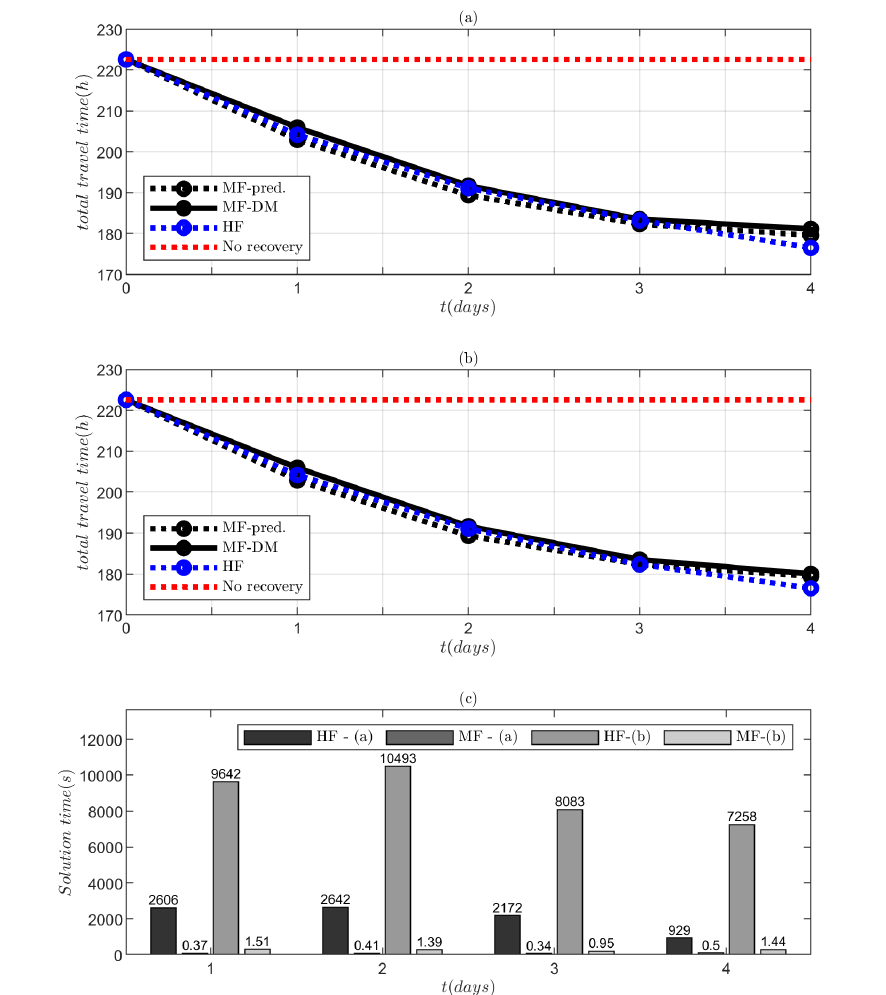
Figure 4. Results of the application of the MF approach to the problem of recovery. (a) Results based on a GA team distribution with a population size of 50 and that converge when no improvement in the fitness function occurs for 20 iterations. (b) Results based on a GA team distribution that uses a population size of 50 and converges when no improvement in the fitness function occurs for 20 iterations. (c) Computational times for